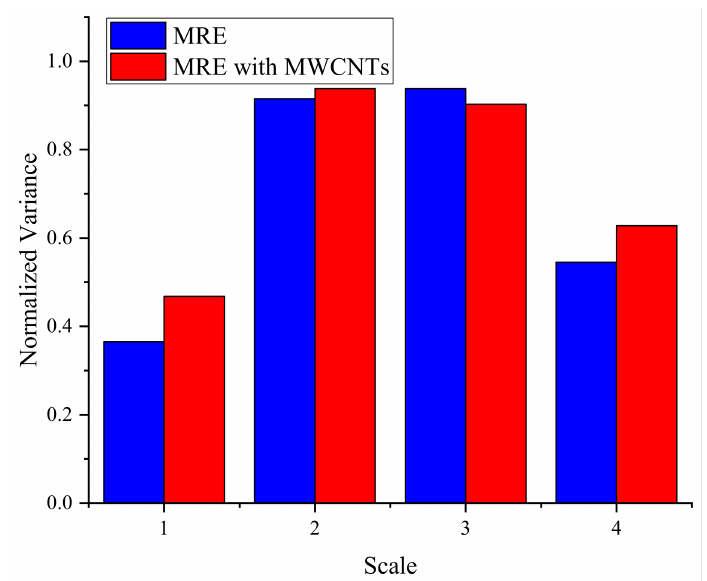
Figure 10. Normalized Variance of Energy